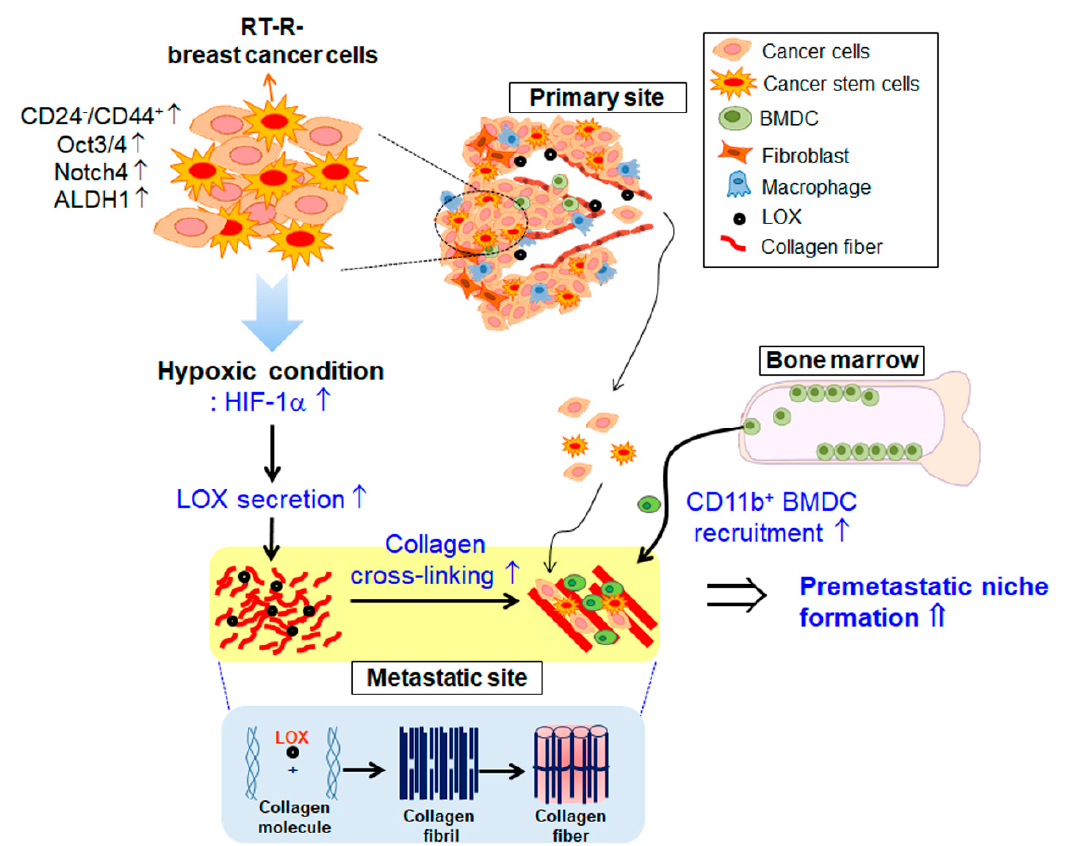
Figure 6. Schematic representation by which RT-R-breast cancer cells increase HIF-1 α expression, leading to secretion of LOX, which contributes to tumor progression by enhancing premetastatic niche formation.